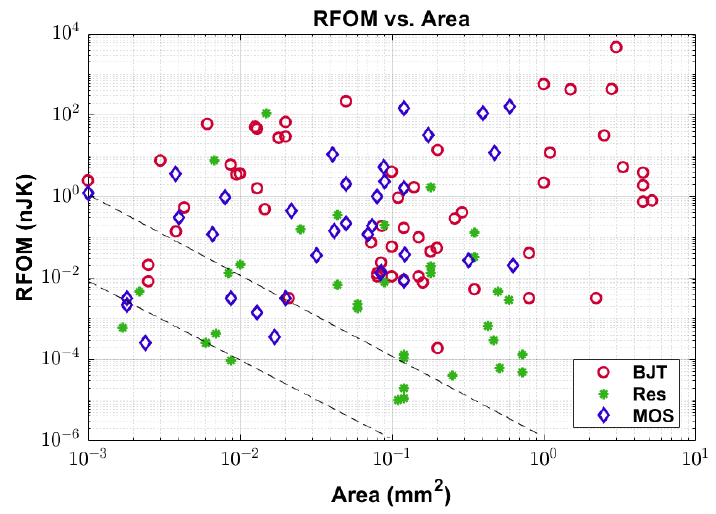
Figure 2. Trade-offs between the resolution figures of merit (RFOM, a measure for energy efficiency) and area, for three types of temperature sensors: the BJT, the resistor and the MOS-based ones. The dashed gray line represents different constant RFOM and the area products.